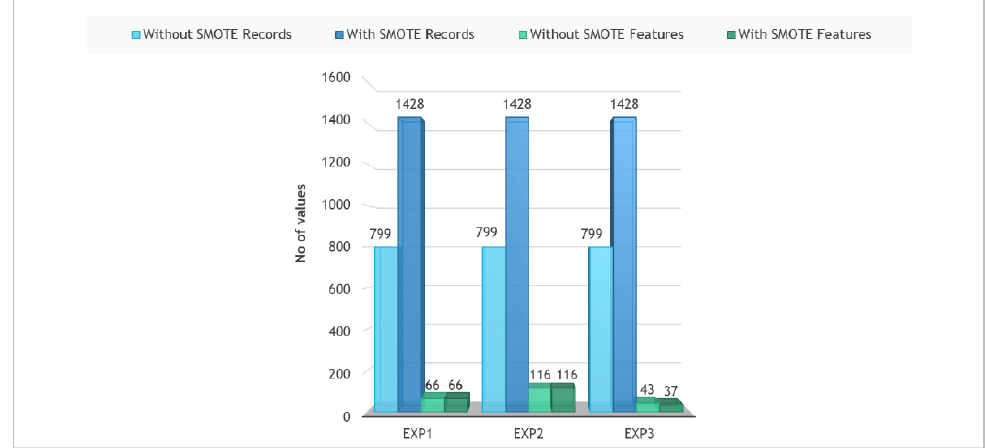
Figure 9. Proposed Methodology.